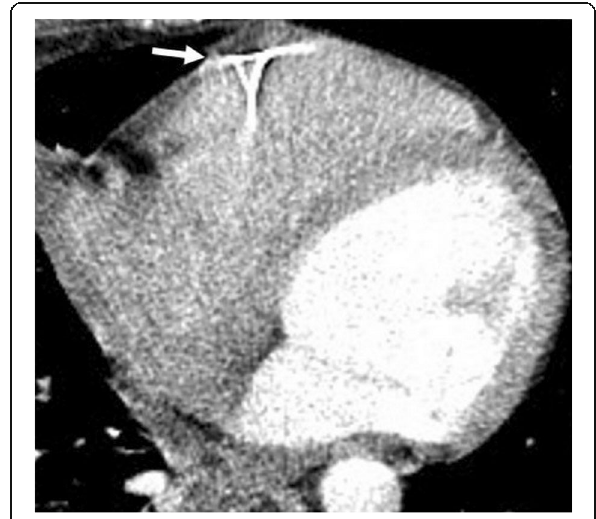
Fig. 27 A 41-year-old war veteran. Axial contrast-enhanced CT image demonstrates a shrapnel fragment abutting the pericardium